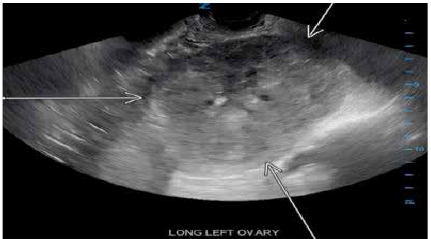
Figure 1: Ultrasound showed a solid hypervascular, mostly hypoechoic, partially isoechoic/partially hypoechoic left ovarian mass measuring 12.6 × 9.8 × 9.4 cm (outline by arrows).